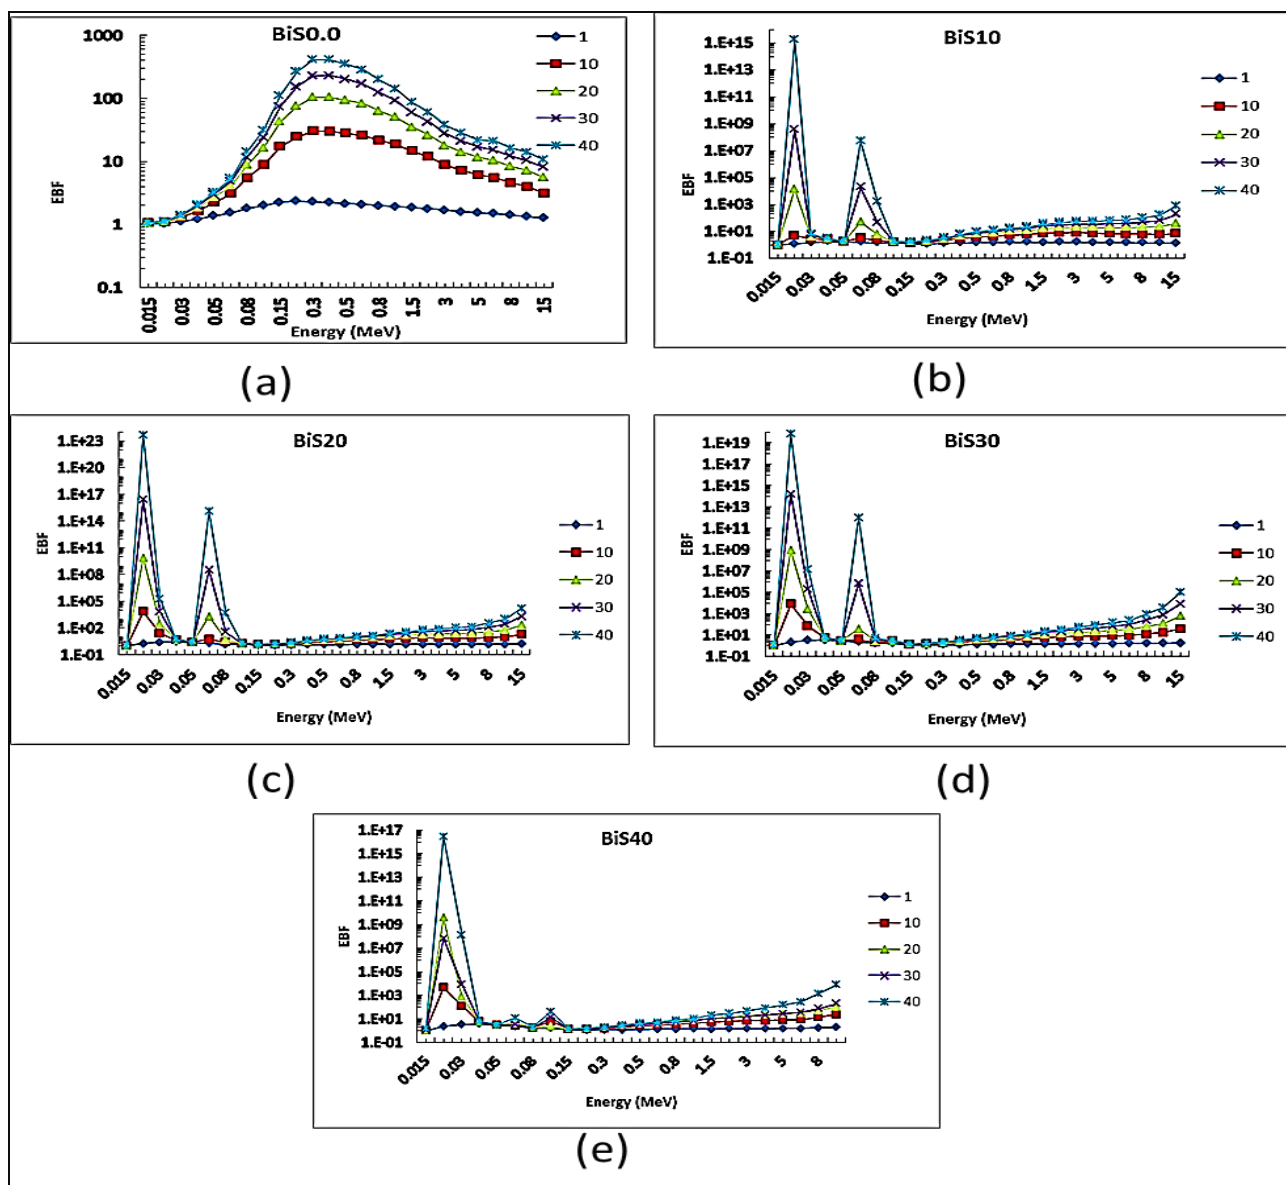
Figure 13. EBF depending on photon energy for all present glass samples: ( a ) Bi0.0, ( b ) Bi10, ( c ) Bi20, ( d ) Bi30, ( e ) Bi40.